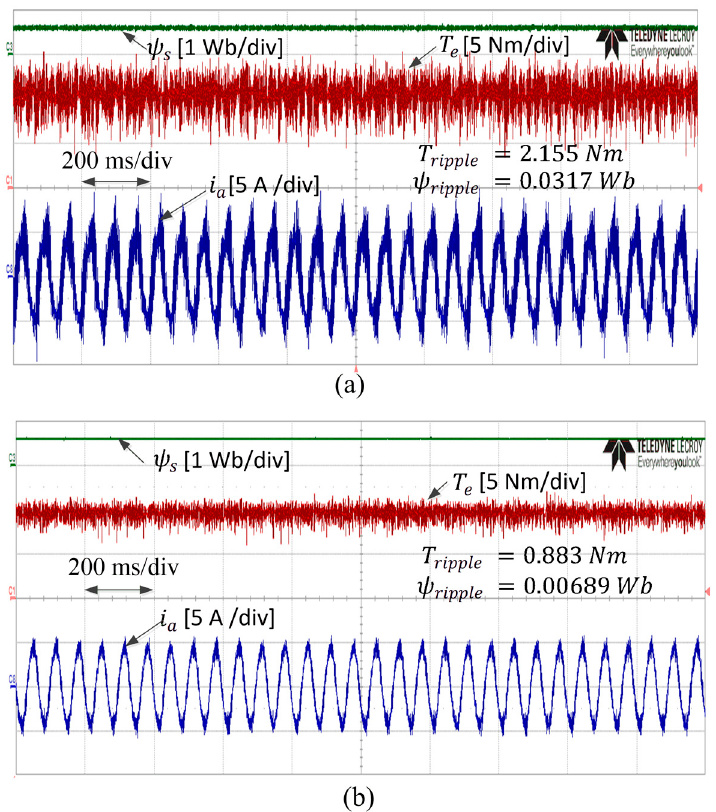
Figure 9. Experimental steady-state response of the PMSM at 300 rpm, 10 Nm. ( a ) Conventional FS-PTC; ( b ) proposed PTC-DSVM.